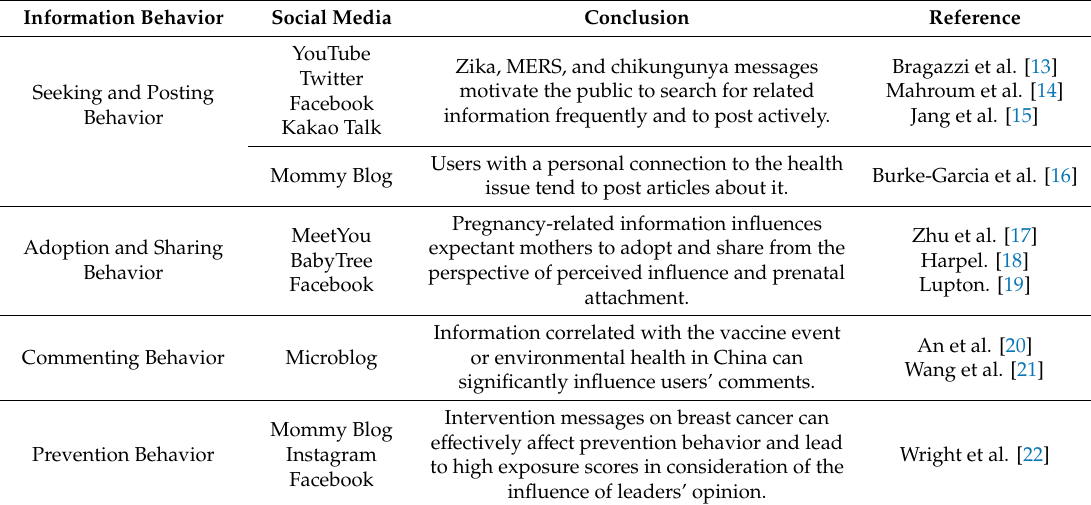
Table 1. Studies on the influence of health information on users’